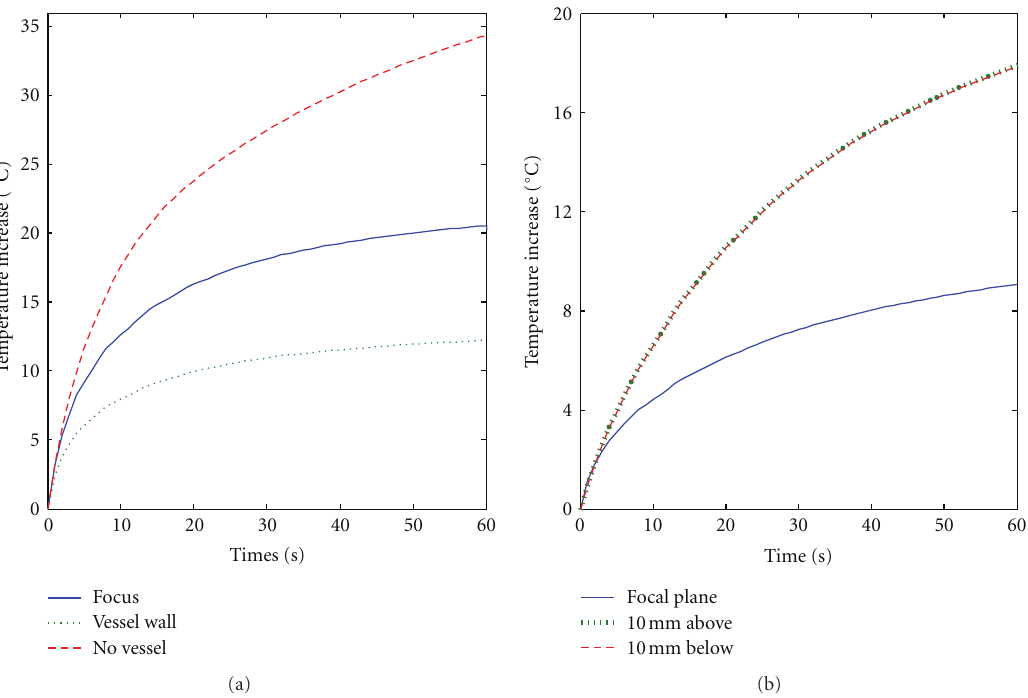
Figure 5: Temperature increase as a function of time for points 1mm away from the vessel wall. The vessel and ultrasound parameters are as in Figure 1 (large artery), except that in (a) the position of the ultrasound focus is 1mm away from the vessel wall and in (b) the vessel makes an angle of 90 ◦ C with the direction of propagation of the ultrasound field. The plots have been obtained through a full 3D simulation.